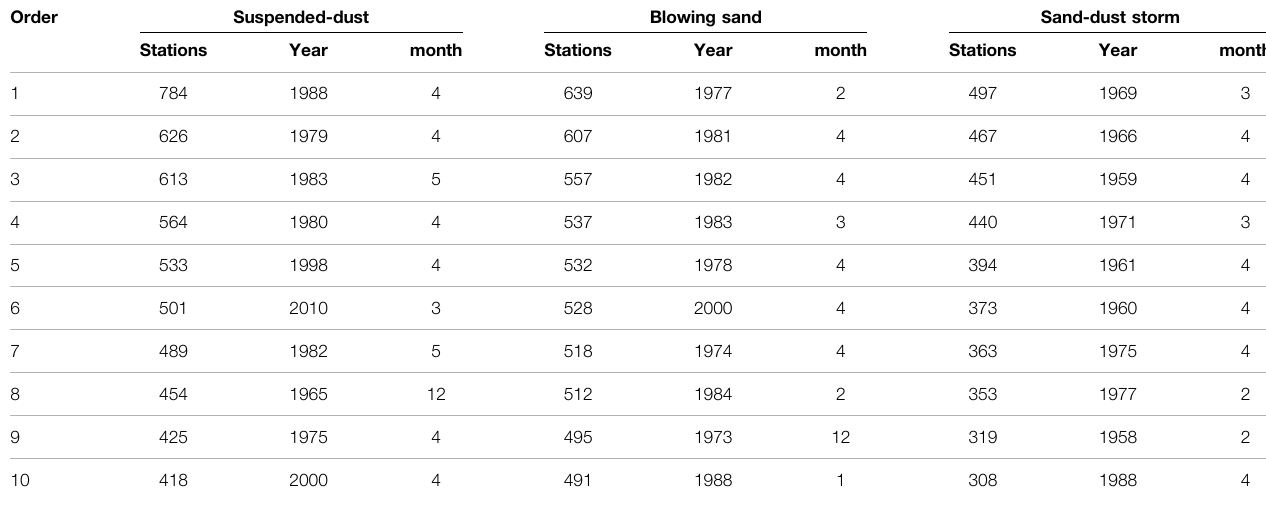
TABLE 1 | The top 10 years with the maximum number of sand-dust stations for different sand-dust categories during 1961 – 2020, and the months with the maximum number of sand-dust stations in the 10 years. Order Suspended-dust Blowing